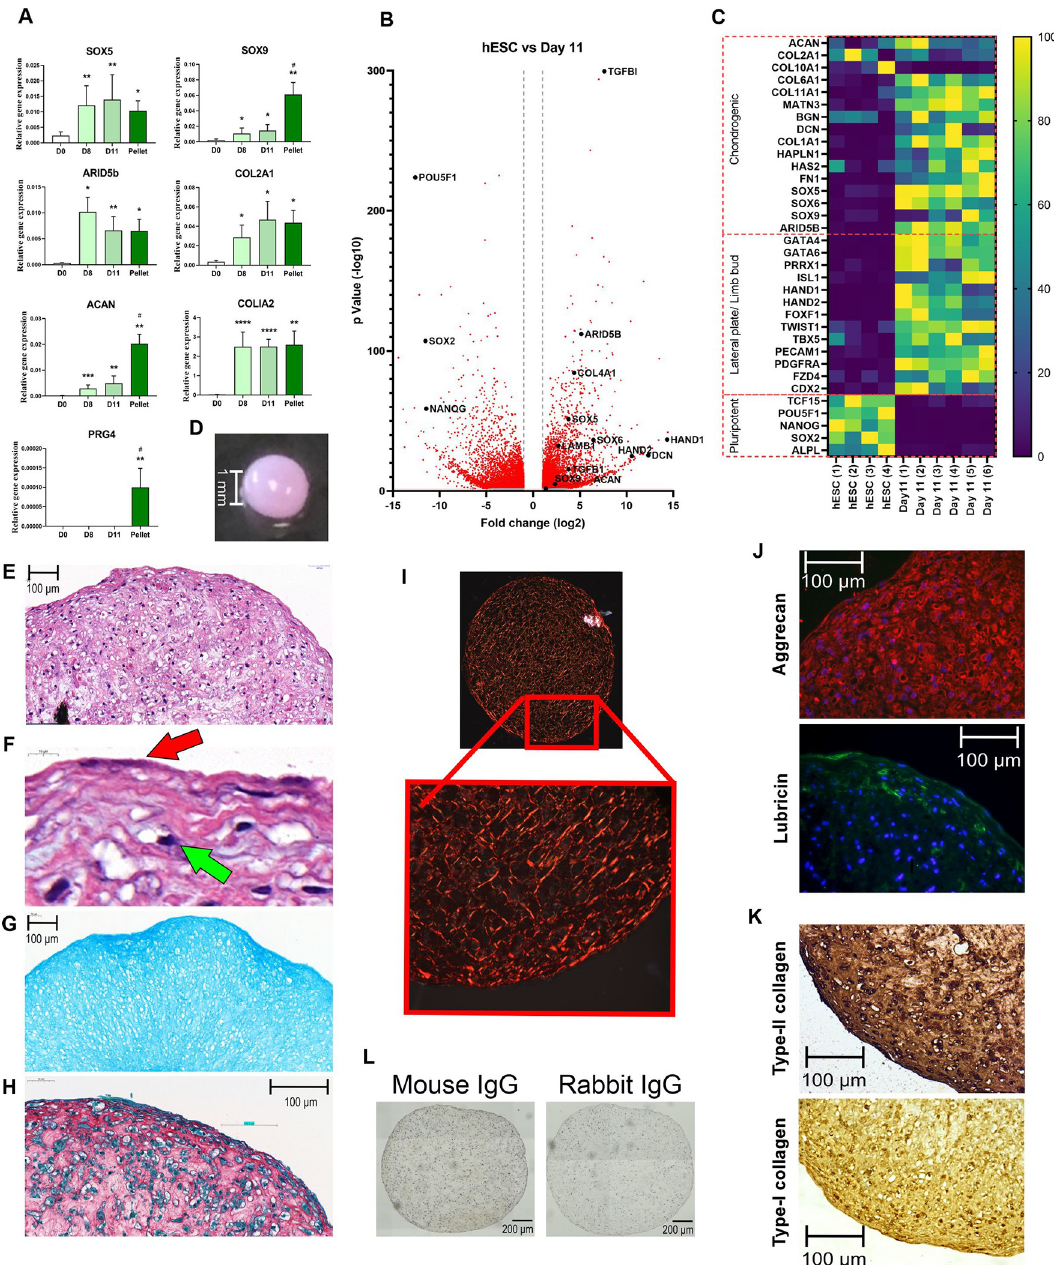
Fig 3. Differentiation of chondroprogenitors through to developing chondrocytes, from limb-bud like progenitor cells. A) QRT-PCR analysis of chondrogenic gene expression during differentiation in 2D (until day 11) and in 3D pellet culture (day 11+14). Gene expression data displayed as relative to housekeeping gene GAPDH +SEM. Mann-Whitney test was used to determine statistical significance relative to hPSCs (day 0) (+ � 0.05, ++ � 0.01, +++ � 0.001). # indicates significant difference to day 11 (N = 5 independent experiments). B) Volcano plot for differential gene expression in day 11 cells (N = 3 independent experiments with duplicate samples) compared to pluripotent hESCs (N = 4 independent experiments). Significant gene changes detected with log2 fold change (log2FC) � 1 or log2FC � -1, with p-value � 0.05. Red plots indicate adjusted p-value � 0.05. Targets of interest are indicated in black and named. C) Heat map of normalised gene expression for target pluripotent, limb bud and chondrogenic gene expression targets in pluripotent (N = 4 independent experiments) and day 11 cells (N = 3 independent experiments with duplicate samples). Data displayed as percentage normalised to lowest and highest expressed for each gene of interest. D) Image at day 11(2D) +28 d in 3D for pellet. E) H&E histological stain of day 11+28 pellet, and F) enlarged view of pellet periphery in H&E including arrows indicating flattened surface cells (red arrow) and cells in lacune (green arrow). G) Alcian blue stain of day11+28 pellet. H) Picrosirius red collagen matrix stain. I) Polarised light imaging of Picrosirius red staining of day 11+28 pellet. J) Immunofluorescence